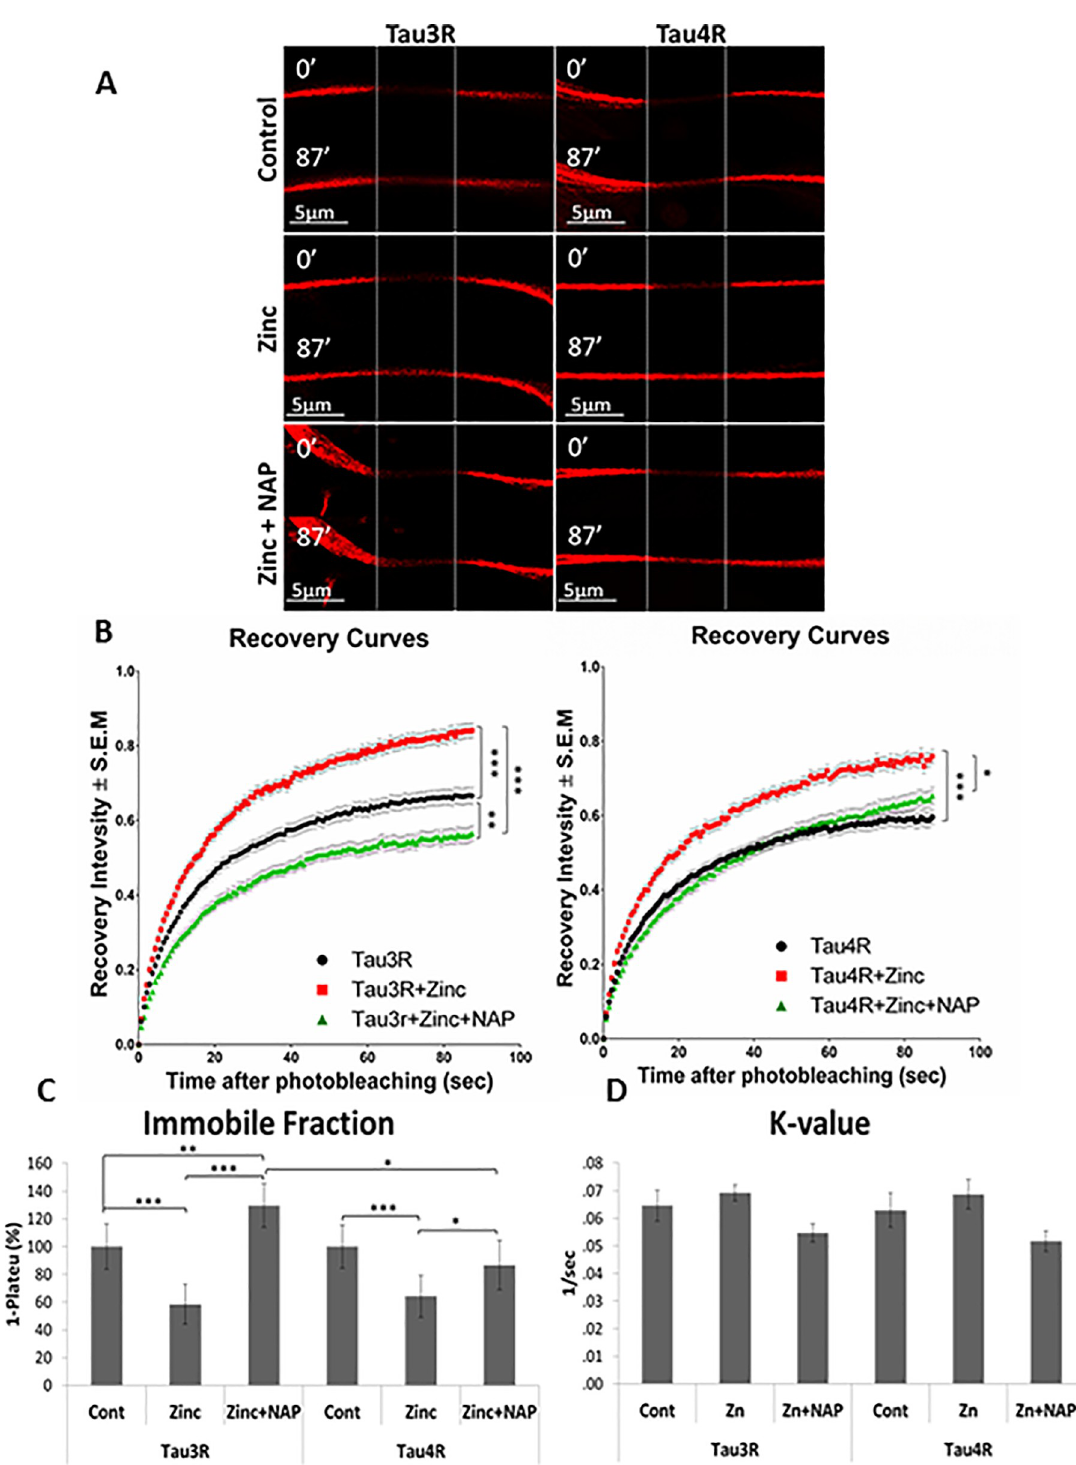
Fig 2. NAP induces increased recruitment of human Tau3R to MTs under zinc toxic condition in comparison to Tau4R. (A) Representative images of photo-bleaching and fluorescence recovery of mCherry-tagged Tau3R and 4R in differentiated N1E-115 cells treated with extracellular zinc (400 μ M, 2hrs) with or without NAP treatment (10 -12 M, 2hrs). N1E-115 cells expressing m-Cherry- Tau3R/4R without any treatment represented the control. (B) FRAP recovery curves of normalized data (see “Materials and Methods”). (C) The graph represents percentages ( ± SEM) of the fitted data (from three independent experiments) of immobile fractions relative to